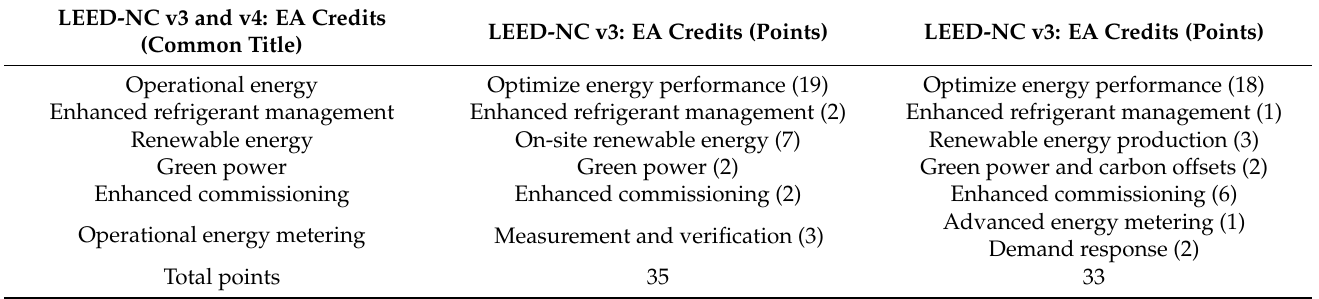
Table 1. Leadership in Energy and Environmental Design (LEED)- New Construction version 3 (v3) and version 4 (v4): Energy and Atmosphere (EA) credits. The numbers in brackets are the maximum points for each EA credit. LEED-NC v3 and v4: EA